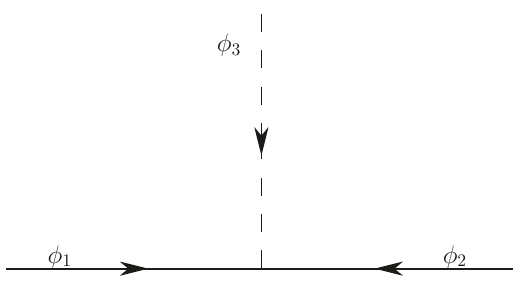
Figure 1 . The supergraph for dimension 4 operators.